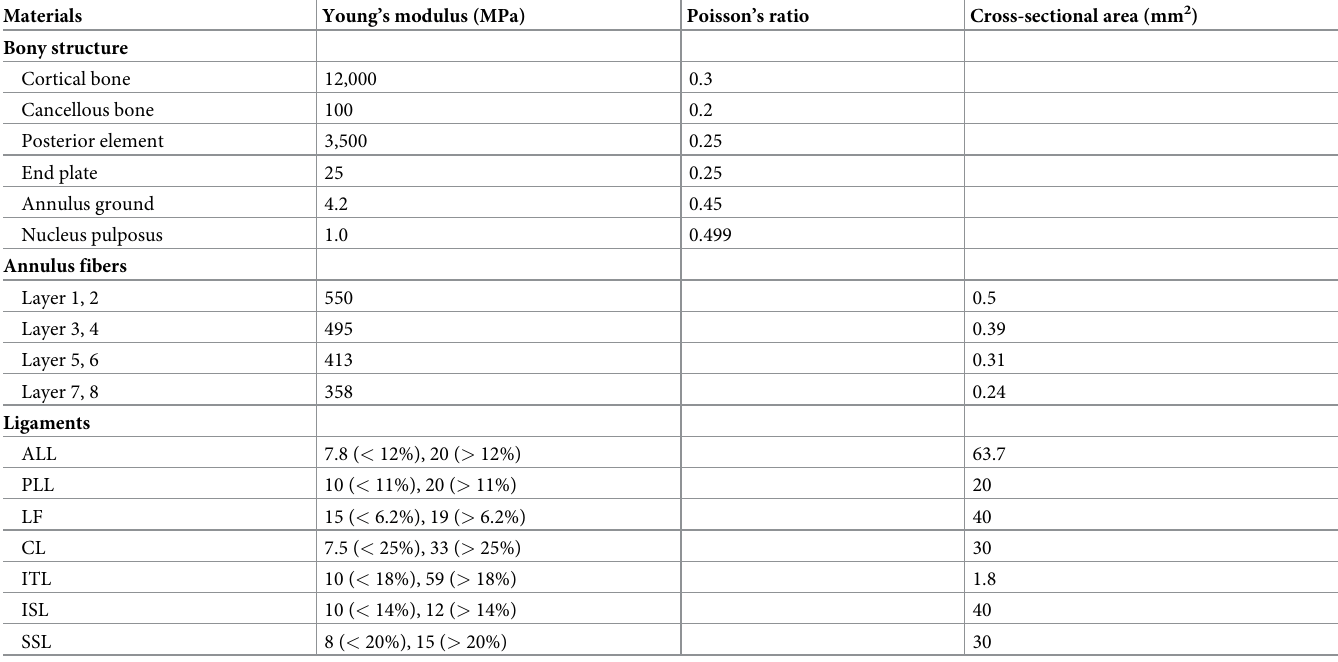
Table 1. Material properties used in the finite element models.